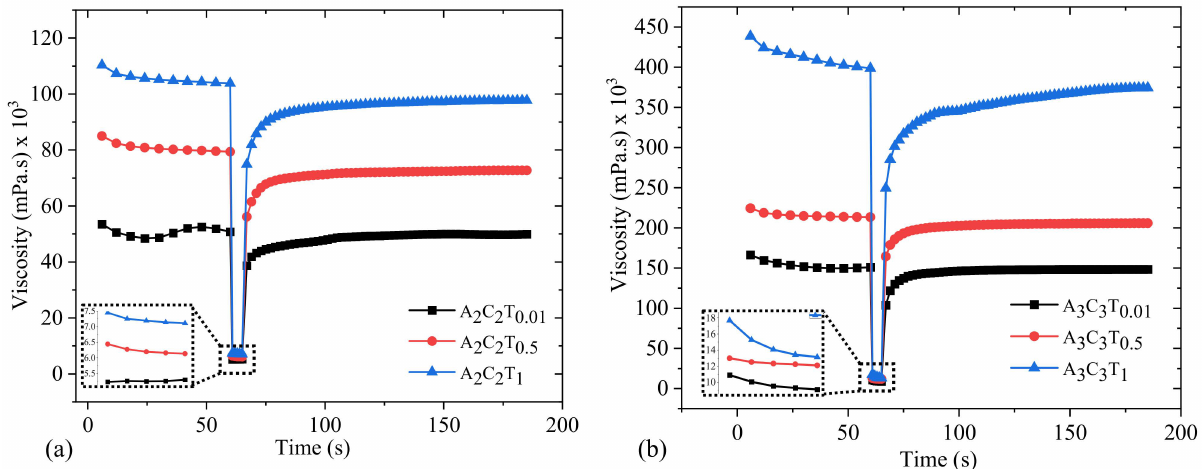
Figure 10. Three-point thixotropic test for the compositions of ( a ) A 2 C 2 T 0.01 , A 2 C 2 T 0.5 , and A 2 C 2 T 1 and ( b ) A 3 C 3 T 0.01 , A 3 C 3 T 0.5 , and A 3 C 3 T 1 . It clearly shows that higher shear rate breaks the internal bonds of the composition, makes it easier to flow through the nozzle during extrusion, and recovers its internal bonds after releasing from the